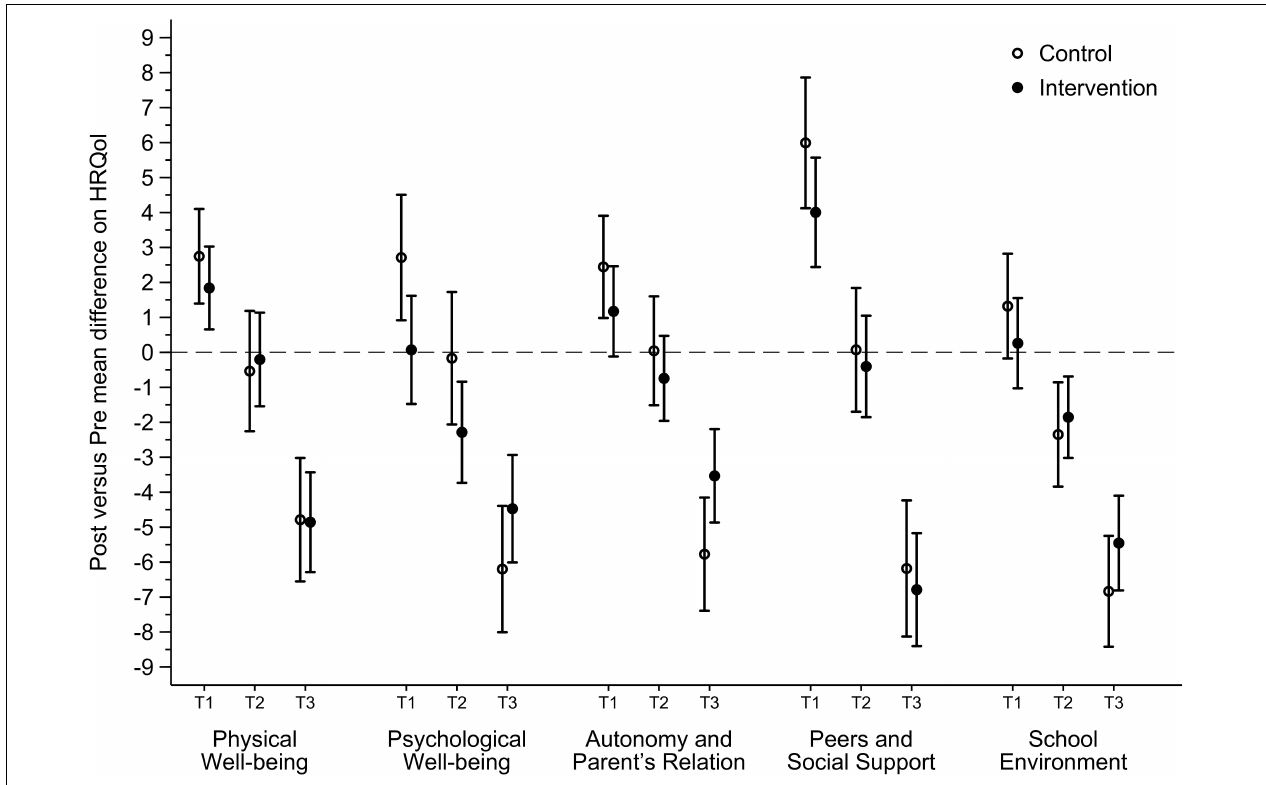
FIGURE 3 | Effect of the Movimente Program on dimensions of HRQoL according the terciles (T1: lower; T2: medium; T3: highest) of HRQoL at